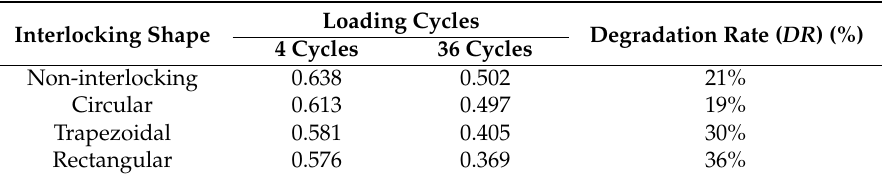
Table 4. Effects of loading cycles on the friction coefficients.